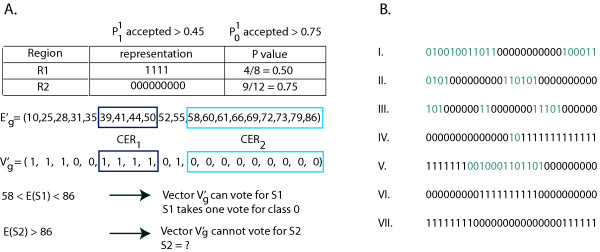
A. Procedure for detection of informative genes and class prediction. The ranked expression profile of gene g (E'g) corresponds to a labeling vector (V'g) which contains two regions that group together a significant number of class 1 and class 0 samples (50% and 75%). These regions map on two CERs: [39-50] and [58-86], respectively. The gene can thus be used for the classification of a new sample S1 in which its expression lies between the respective thresholds of CER2, but not for a sample S2. B. Examples of labeling vectors -that correspond to informative genes- identified by our method. Vectors V and VI are of particular biological interest as they divide samples of class 0 and 1 respectively, in two distinct sub-groups.